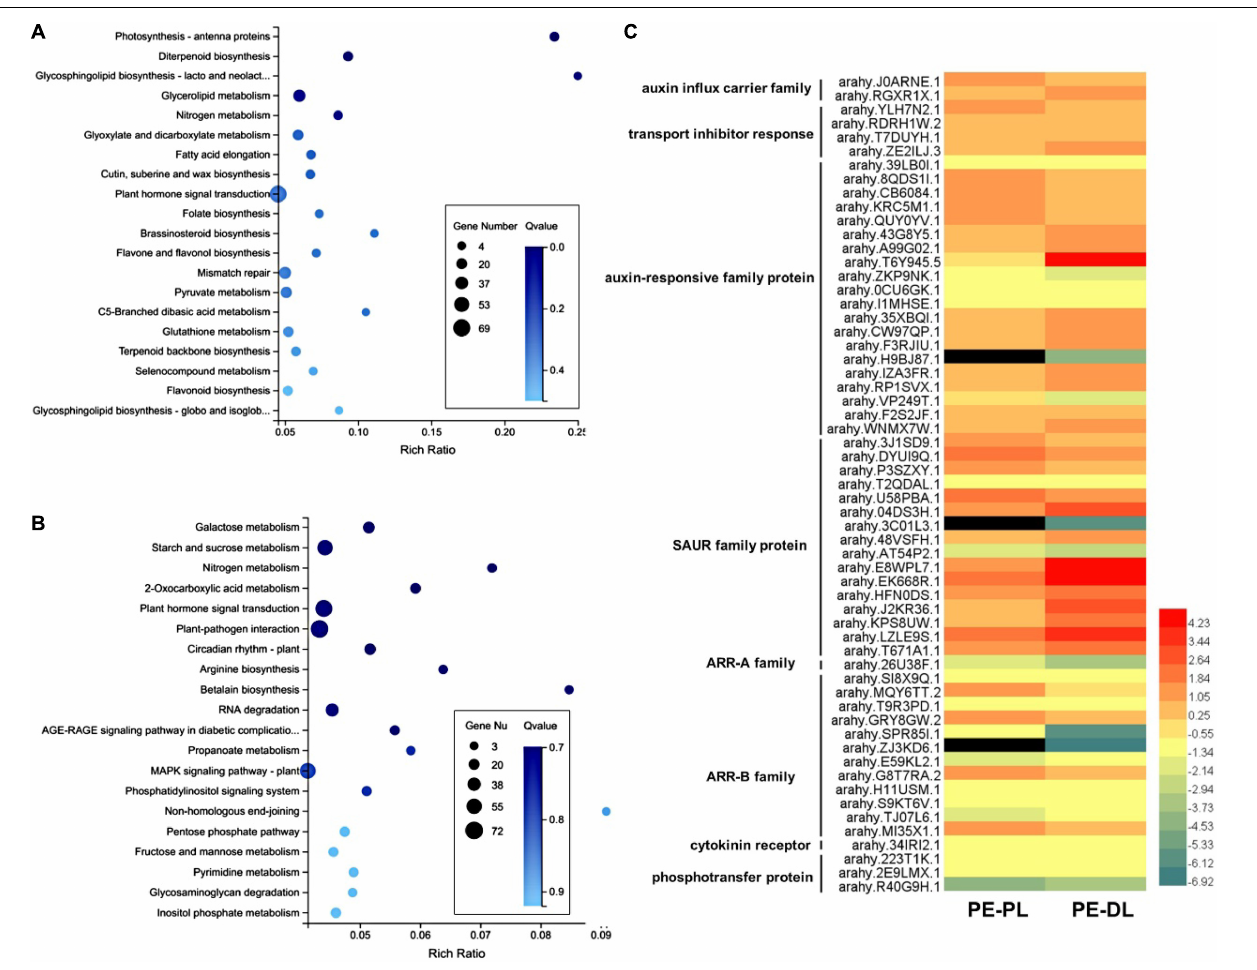
FIGURE 2 | Analysis of differentially expressed genes (DEGs) in proximal and distal leaflets in A. hypogaea . (A) KEGG enrichment analysis of DEGs in distal leaflets. (B) KEGG enrichment analysis of DEGs in proximal leaflets. (C) A heatmap of DEGs enriched in auxin and cytokinin (CK) signaling transduction pathway between proximal and distal leaflets. PL, proximal leaflet, DL, distal leaflet, PE,